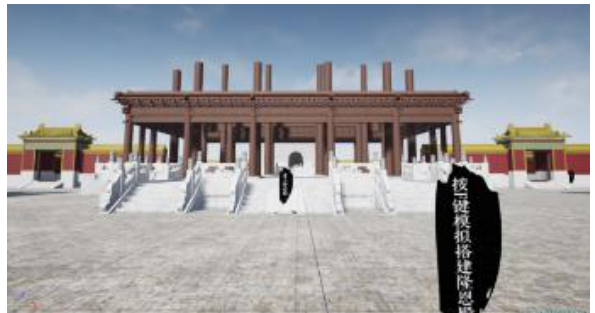
Figure 16. The animation of the reconstruction